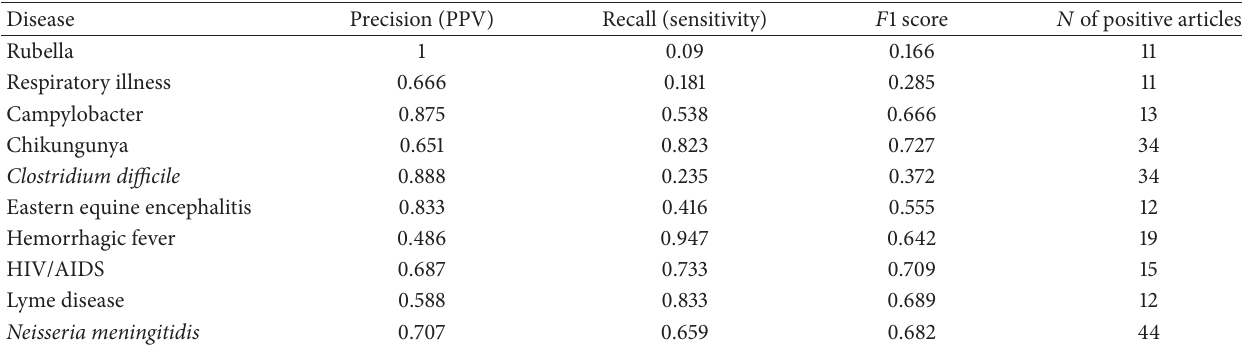
Table 3: GRITS’ bottom 10 performing disease